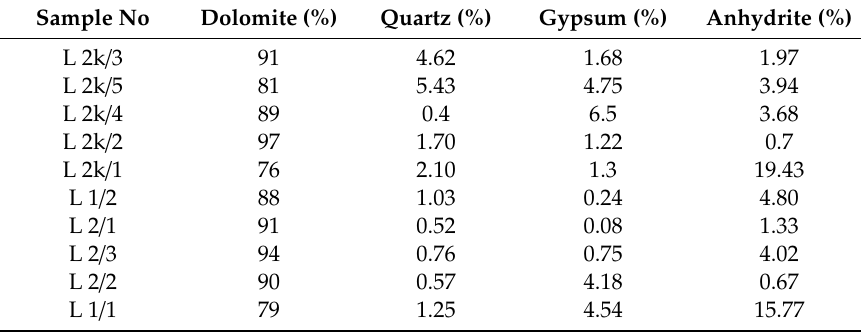
Table 3. Percentages of major minerals in the samples, X-ray di ff raction (XRD)